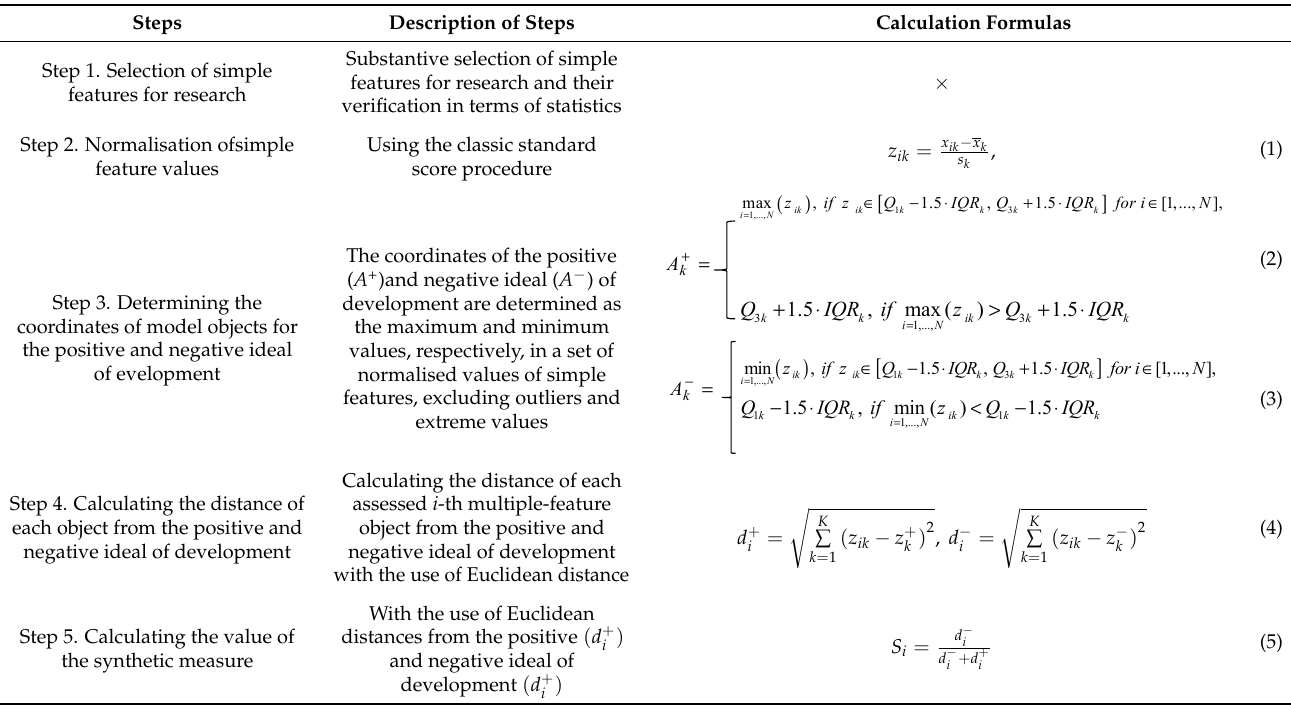
Table 1. The stages of constructing a synthetic measure of the rural commune investment activity level using the TOPSIS method.